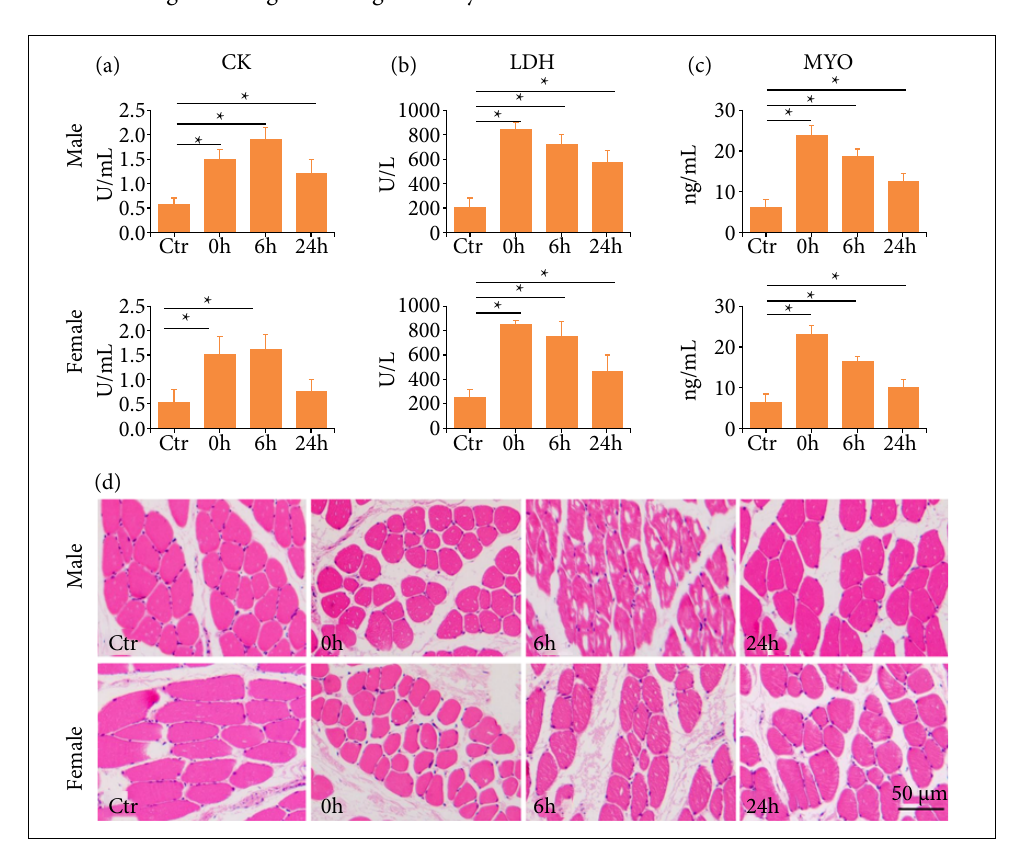
Figure 1 - One-time high-load exercise induce muscle injury in rats; (a) the activity of serum CK; (b) The activity of serum LDH; (c) The concentration of serum MYO; (d) The histological changes of muscles by H&E staining. *p < 0.05 compared with control